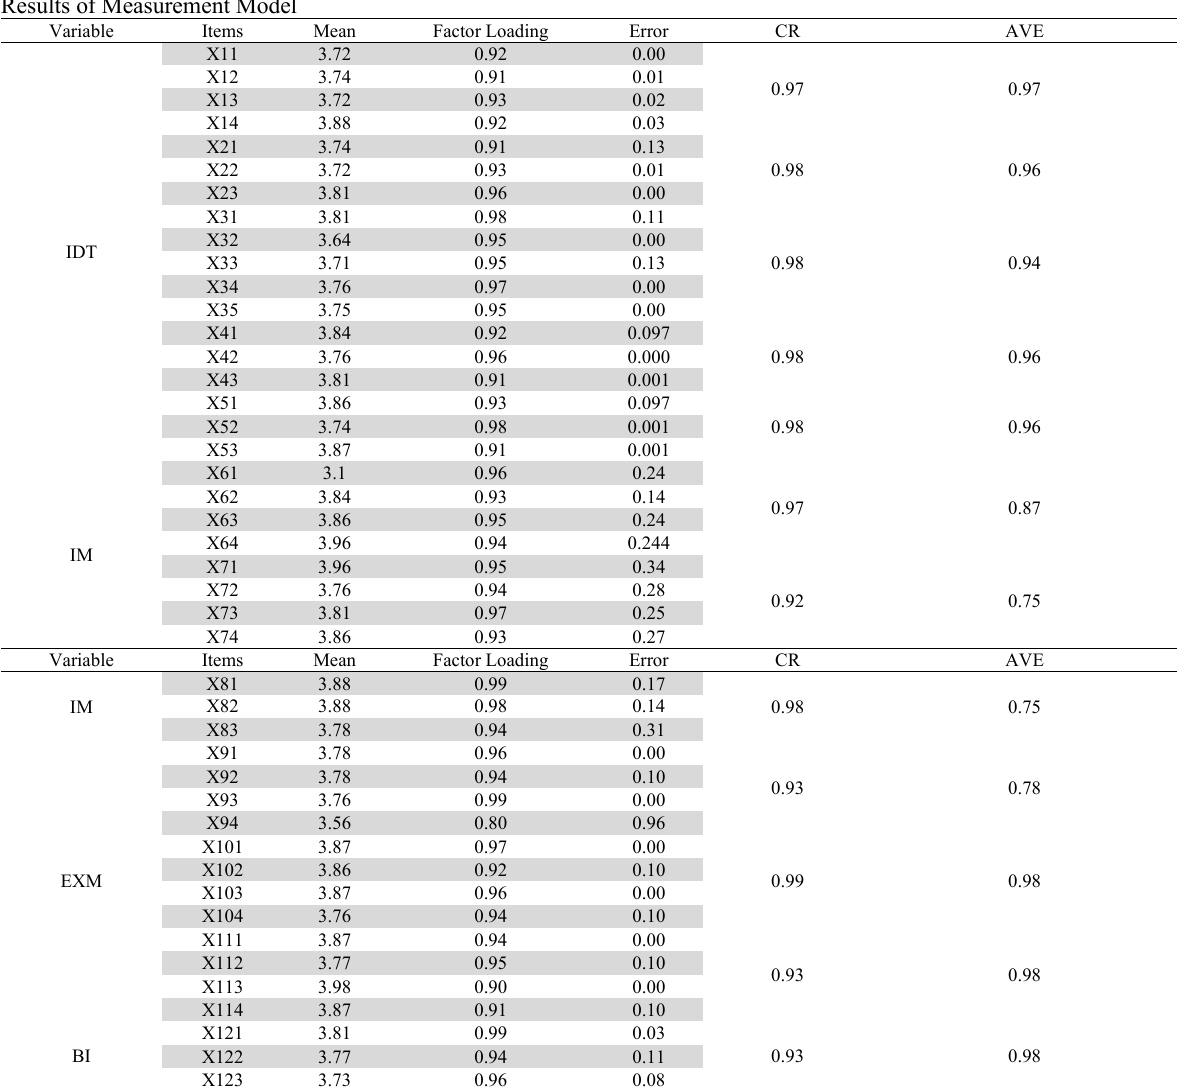
Results of Measurement